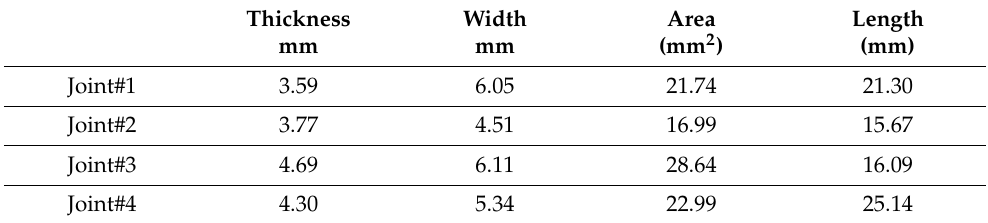
Table 2. Properties of ACL tissue for mechanical